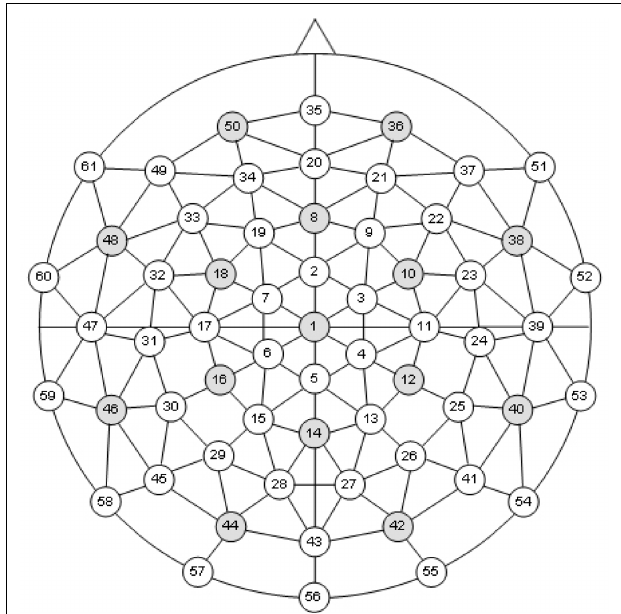
FIGURE 1 | Electrode array with locations in gray indicating approximate 10–20